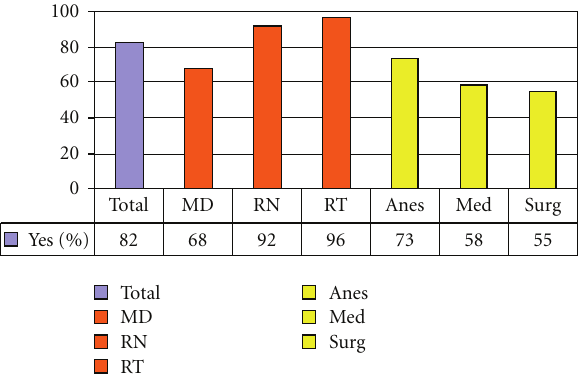
Figure 9: Aware of Emergency Airway Access Form.